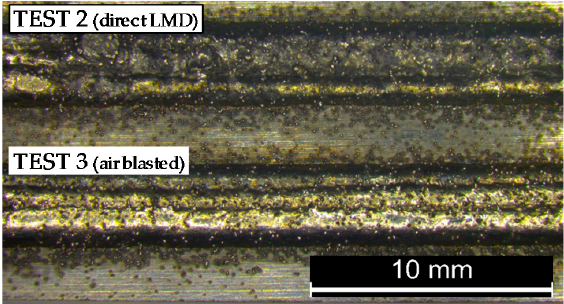
Figure 5. External appearance of tests No. 2 and 3.